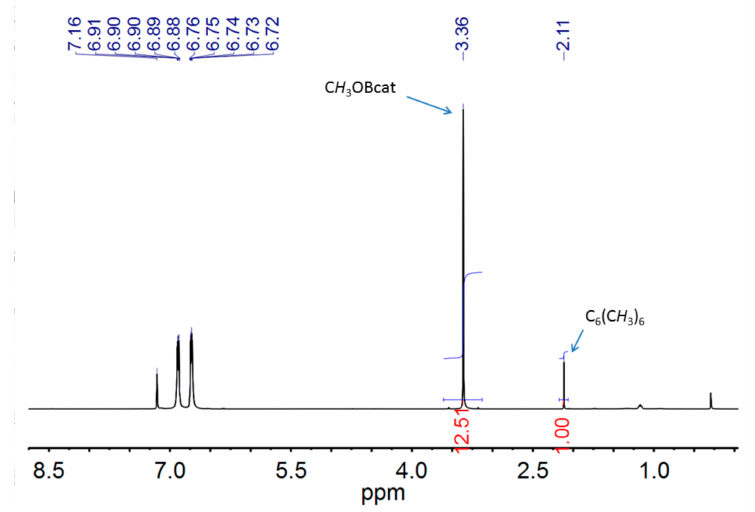
Figure 3. 1 H NMR spectrum for the hydroboration of CO 2 with HBcat catalyzed by complex 1a in benzene- d 6